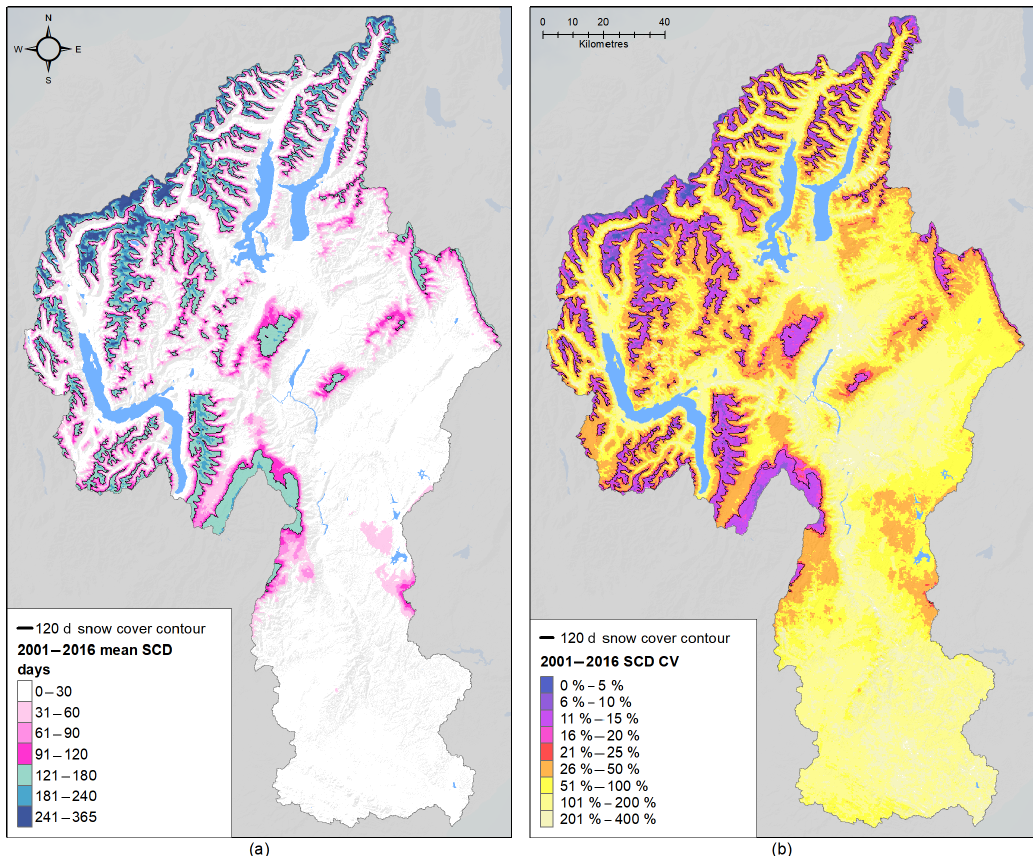
Figure 5. Mean annual SCD ( µ SCD ) (a) , and associated coefficient of variation, CV (CV SCD ) (b) , for the Clutha Catchment, 2001–2016. Elevation and relief data from Columbus et al. (2011); lake outlines are sourced from the LINZ Topographic